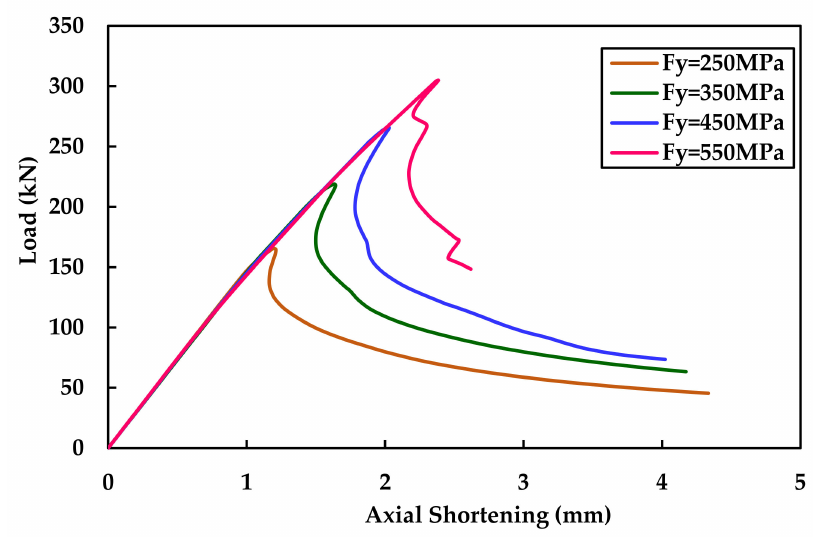
Figure 19. Load versus axial shortening behaviour of FISCS-3.